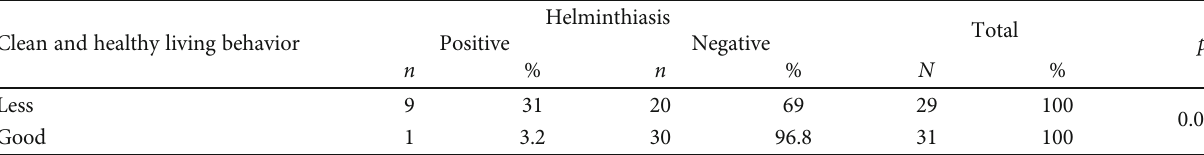
Table 3: Clean and healthy living behavior and helminthiasis.